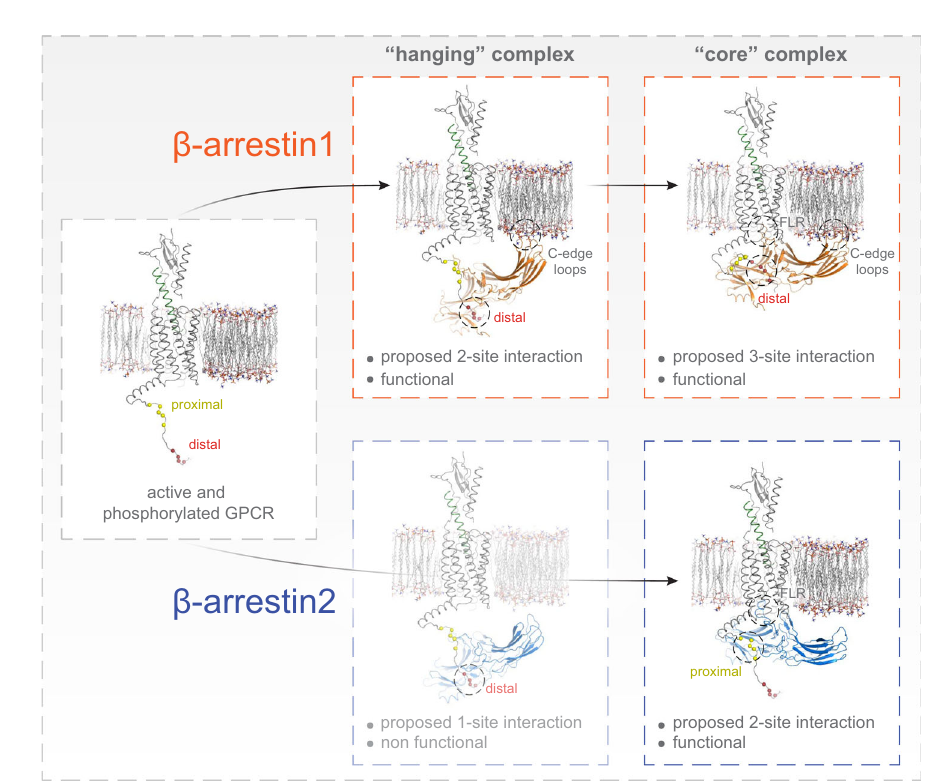
Fig. 7 | Possible geometry of ‘ hanging ’ and ‘ core ’ complex con fi gurations betweenPTH1Rand β -arrestin1and2. Molecularmodellingofdifferentlyformed ‘ hanging ’ and ‘ core ’ complex con fi gurations between the active and phosphory- lated PTH1R (PDB: 6NBF) and β -arrestin1 (PDB: 4JQI) and 2 (PDB: 6K3F), respec- tively.Theresultsfor β -arrestin1interactionswiththePTH1Raredepictedinthetop row, while the bottom row shows analogous results obtained for β -arrestin2. Our data suggest that β -arrestin1 (top row) interactions with the PTH1R rely more strongly on the distal phosphorylation sites, while the proximal phosphorylation does not seem to stabilise these complexes. Additionally, for β -arrestin1 both ‘ hanging ’ and ‘ core ’ PTH1R – β -arrestin1 complex con fi gurations are presumably stabilised by membrane anchorage of the exposed C-edge loops 47 . Hence,